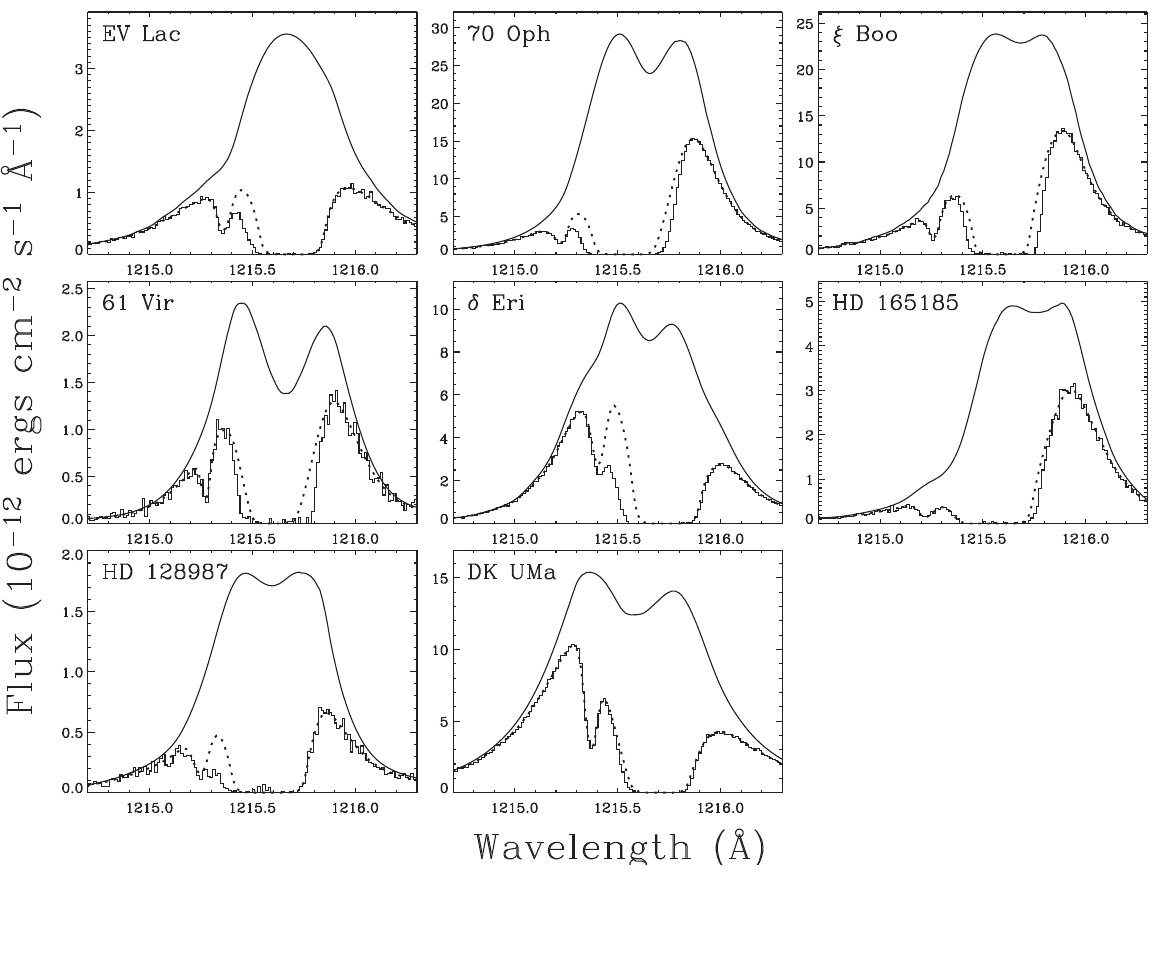
Figure 6. Lyman- α line profiles of 8 stars : EV Lac (M3.5 V), 70 Oph A (K0 V), ξ Boo A (G8 V), 61 Vir (G5 V), δ Eri (K0 IV), HD 165185 (G5 V), HD 128987 (G6 V), and DK UMa (G4 III-IV). Histograms are HST/STIS observations, thin solid lines are the reconstructed-Lyman- α line profiles, and dashed lines show the intrinsic line profiles after interstellar absorption. The additional absorption on either side of the interstellar absorption is produced by hydrogen in the stellar astrosphere (blue side) and the heliosphere (red side). Figure from Wood et al . with copyright permission